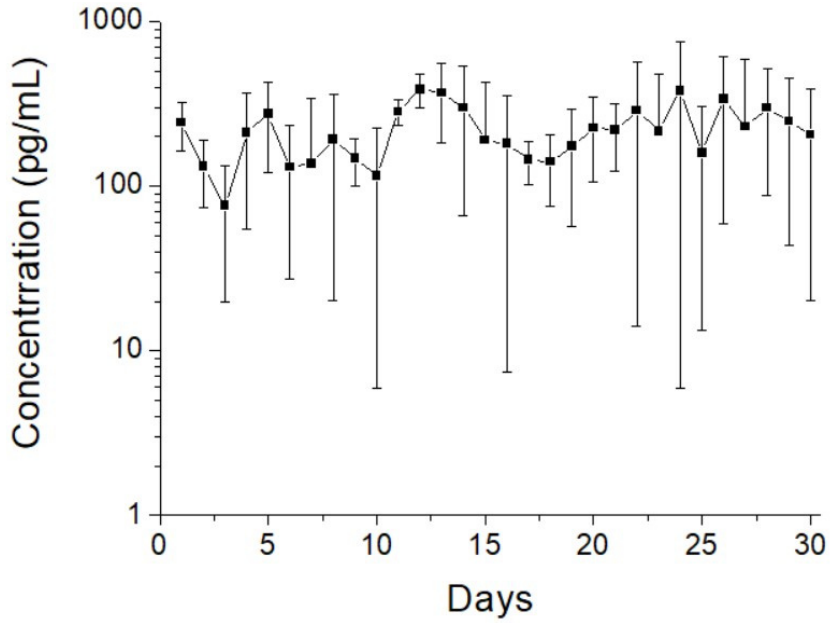
Figure 9. In vitro elution profile of BMP-2 from the sheath–core-structured nanofibers.